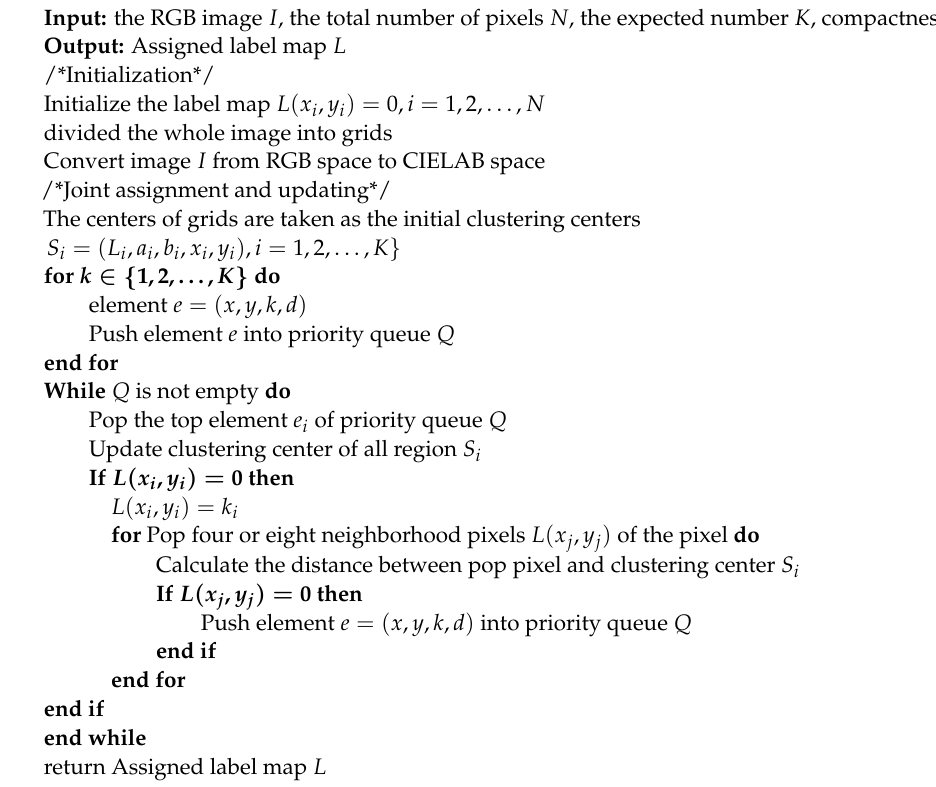
Algorithm 1. SNIC segmentation algorithm